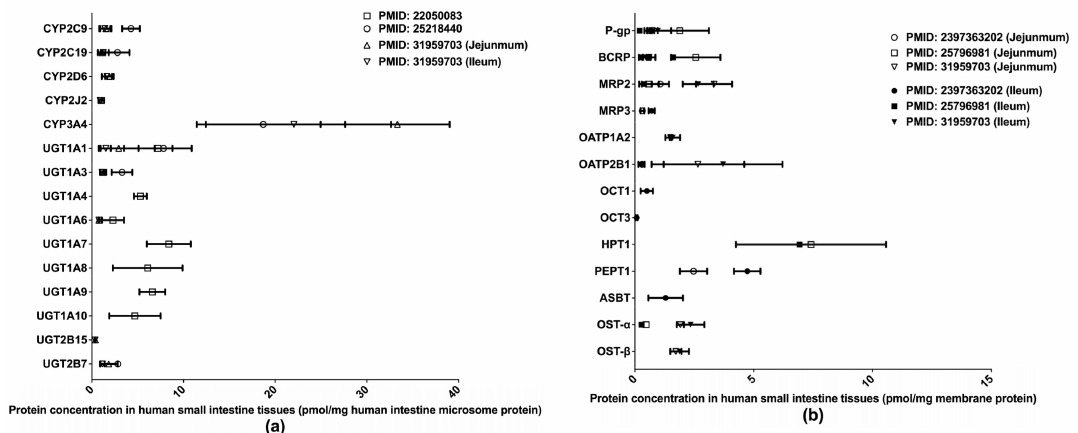
Figure2. AbsolutequantificationofmajorclinicallyrelevanthumanintestinalDMEs( a )andtransporters ( b ). Protein expression levels are presented as means with standard deviations. CYP: cytochromes P450; UGT: uridine 5 (cid:48) -diphospho-glucuronosyltransferase; P-gp, P-glycoprotein; BCRP, breast cancer resistance protein; MRP: multidrug resistance-associated protein; OATP: organic anion transporting polypeptide; OCT: organic cation transporter; HPT: human peptide transporter; PEPT: Peptide transporter; ASBT: apical sodium–bile acid transporter; OST: organic solute transporter